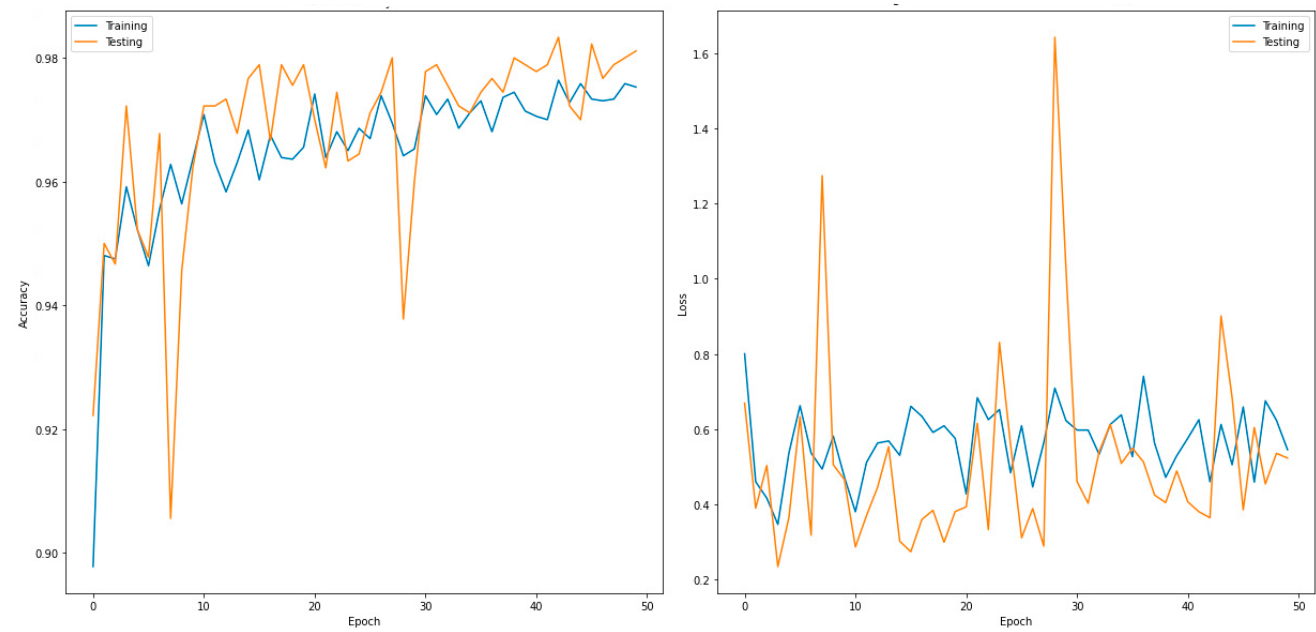
Table 7. Performance metrics of DenseNet201 for three-class classifier.